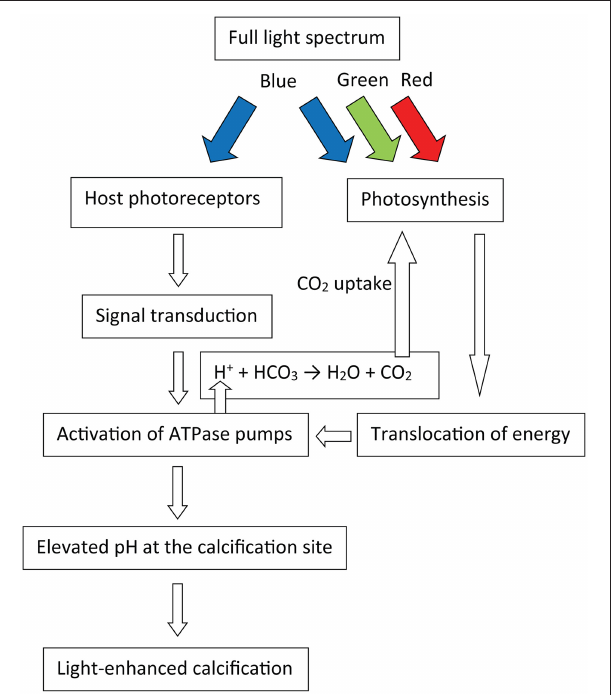
FIGURE 6 | Schematic model suggested for the mechanism of light-enhanced calcification in corals, colored arrows represent their light